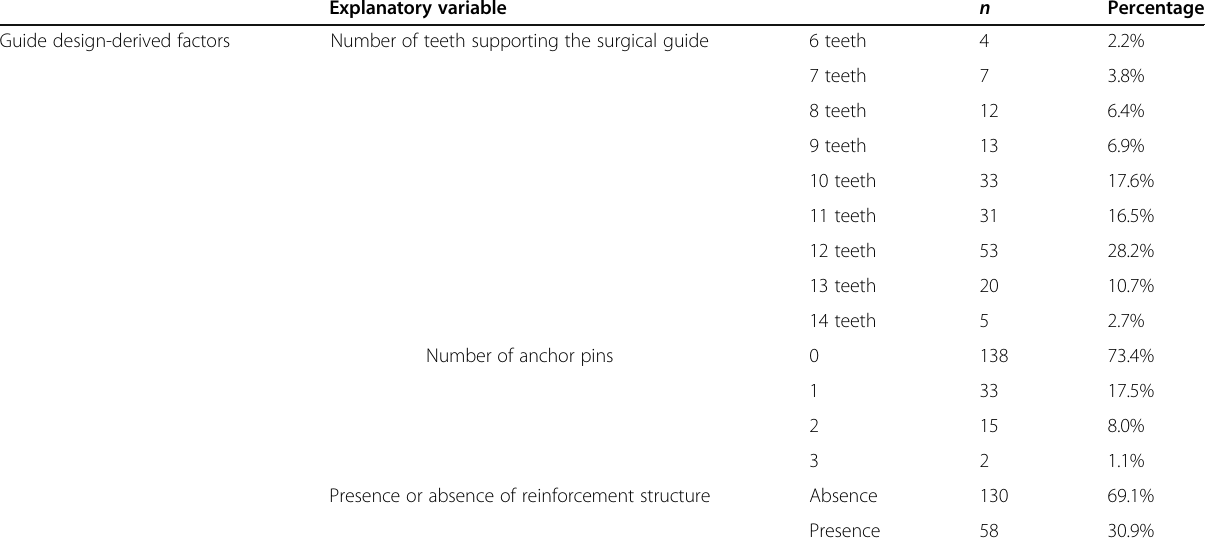
Table 5 Baseline data of explanatory variables Explanatory variable n Guide design-derived factors Number of teeth supporting the surgical guide